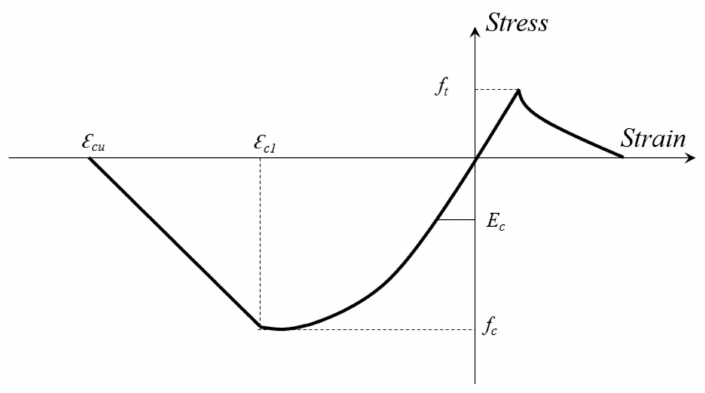
Figure 17. Uniaxial stress versus strain law for concrete ( f c = 18 MPa, f t = 2.29 MPa, E c = 19.94 GPa, ε c1 = 0.0034, ε c2 = 0.0048).